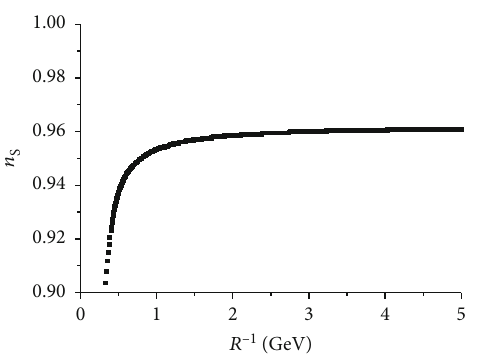
Figure 2: The spectral index in the intermediate scenario as a function of R − 1 for R 0 : 1 , A = 1 , and f = 1/2 .